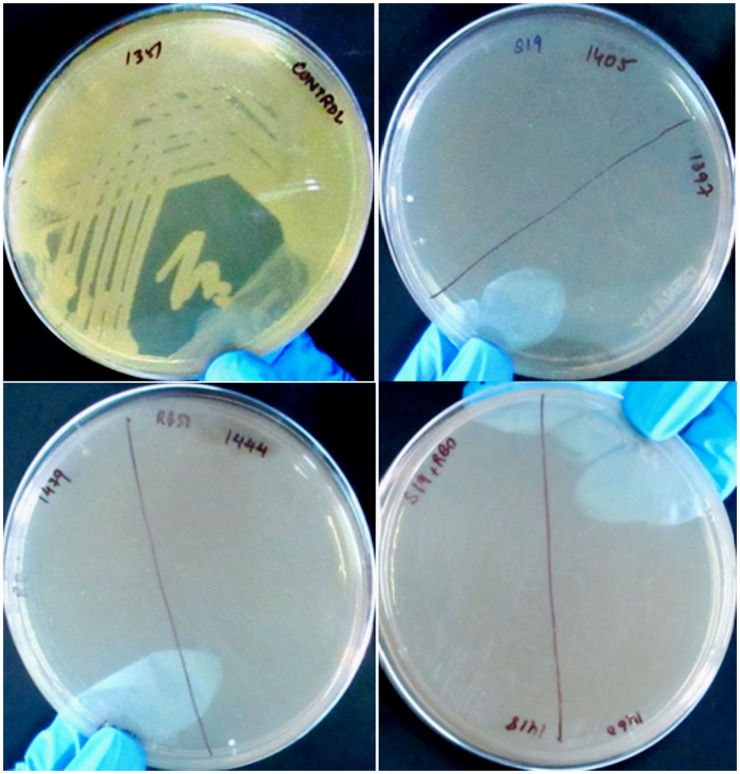
Culture of Brucella from blood of treated or untreated cattle.Top left: untreated, top right: S19 lysate treated, bottom left: RB51 lysate treated, and bottom right: cocktail lysate treated cattle.